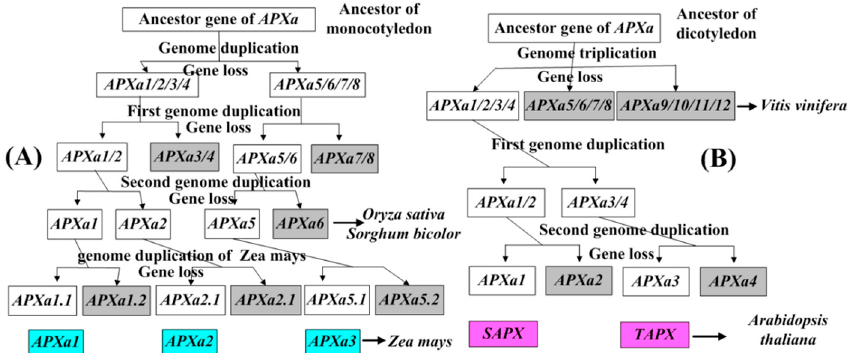
Figure 9. A model for the evolution of the angiosperm APX genes of class A. ( A ) A model for the evolution of monocotyledon. ( B ) A model for the evolution of dicotyledon. Gray columns indicate missing genes. The genes from A. thaliana and maize are labeled by pink columns and blue columns, respectively.